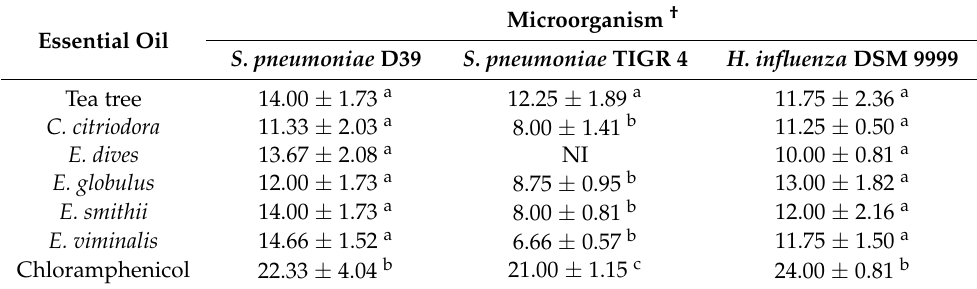
† Data represent the mean ± standard deviation of three replicates. Data with the same superscript letter are not significantly different ( p > 0.05). NI: No